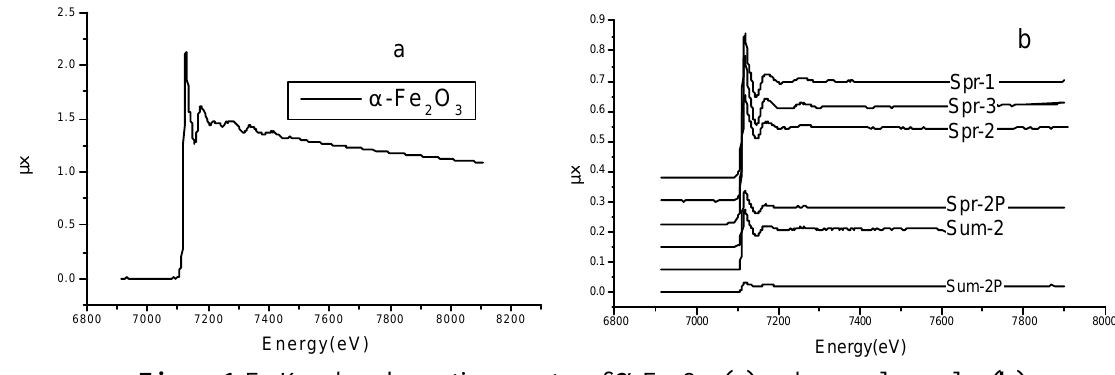
O ( a ) and aerosol samples ( b ). 2 3